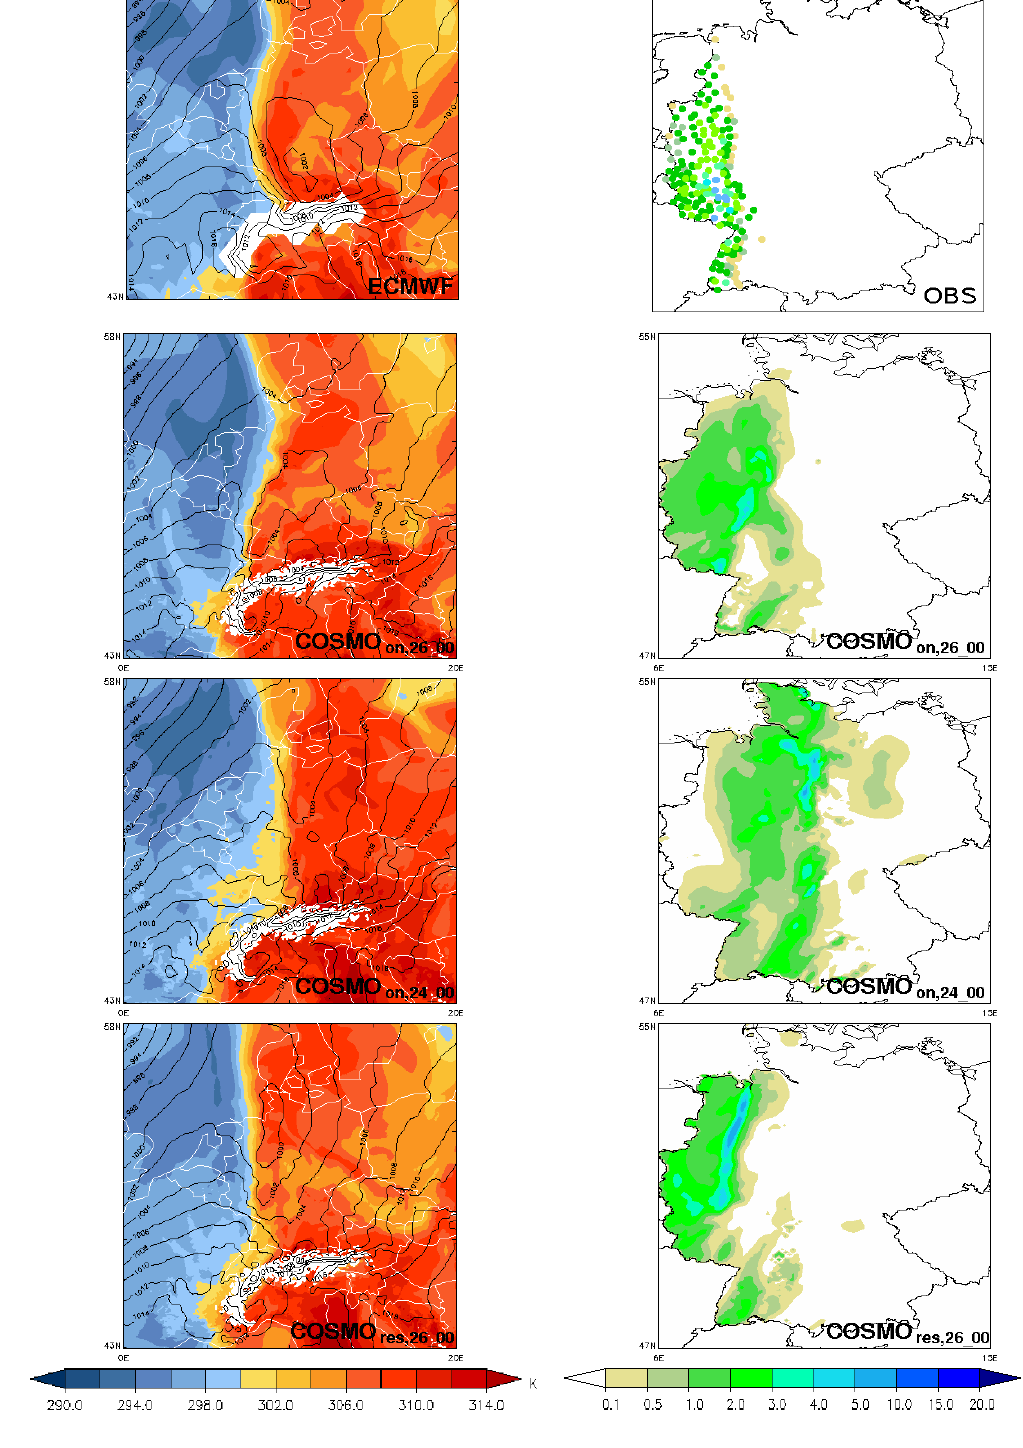
Fig. 13. Left: equivalent potential temperature ( Θ e ) at 850hPa (colours, in K) and contours of SLP (in hPa) at 12:00UTC 26 March 2010. Right: 1h-accumulated precipitation for 11:00–12:00UTC 26 March 2010 (in mm).